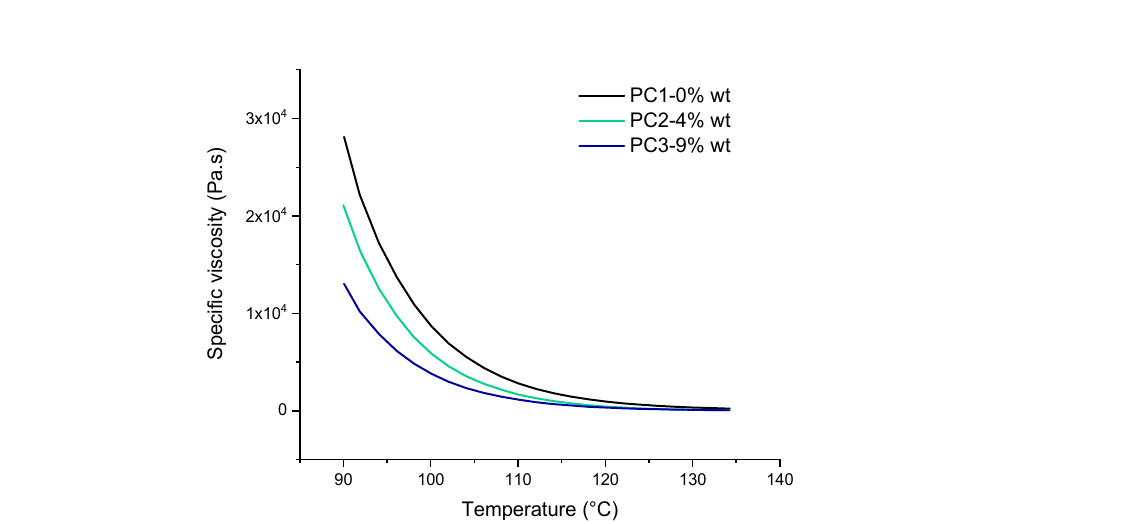
Figure 6. The specific viscosity of uncured basic urethane powders upon heating from 90 to 135 ◦ C.